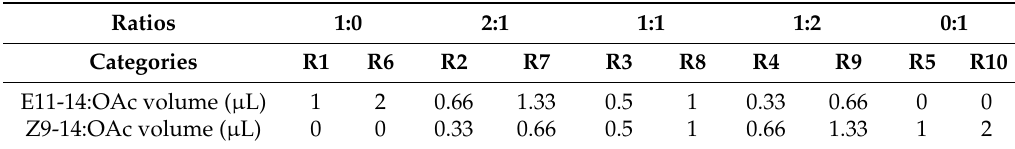
Table 1. Ratios of the two pheromones used to demonstrate the basic principle of ratiometric infochemical